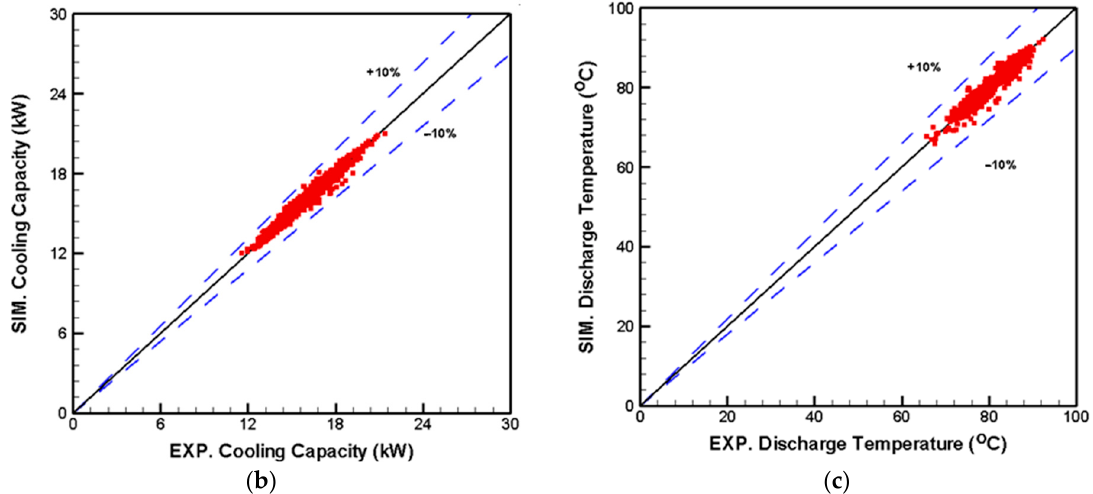
Figure 6. Validation of the ( a ) COP, ( b ) cooling capacity, and ( c ) discharge temperature at low temperature application. Figure 7 represents the field measurement results of the supermarket refrigeration